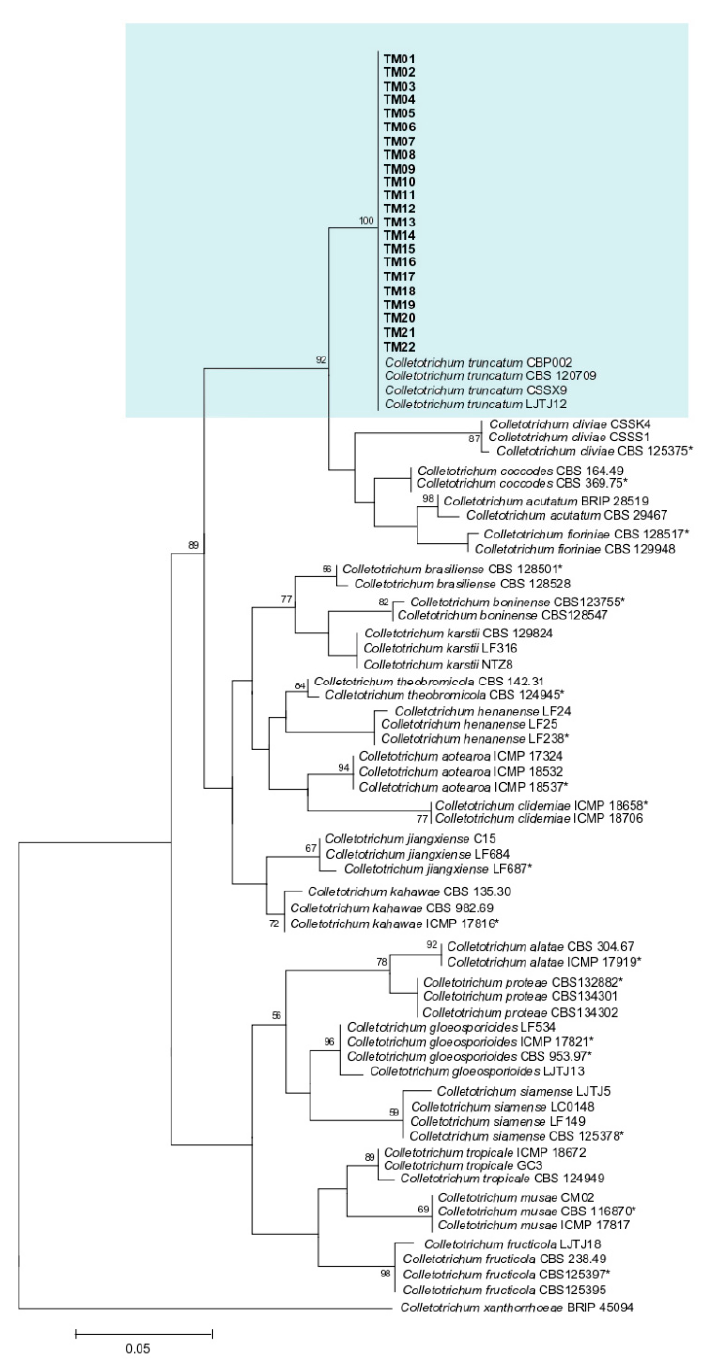
Figure 3. Maximum likelihood (ML) tree of Colletotrichum truncatum generated from analysis of the concatenated ITS region, tub2 , gapdh, act and cal genes, with Colletotrichum xantharrhoeae as outgroup. Asterisks indicate ex-type isolates. The isolates used in the present study are indicated in bold font and highlighted in. Only bootstrap values > 50% are shown.